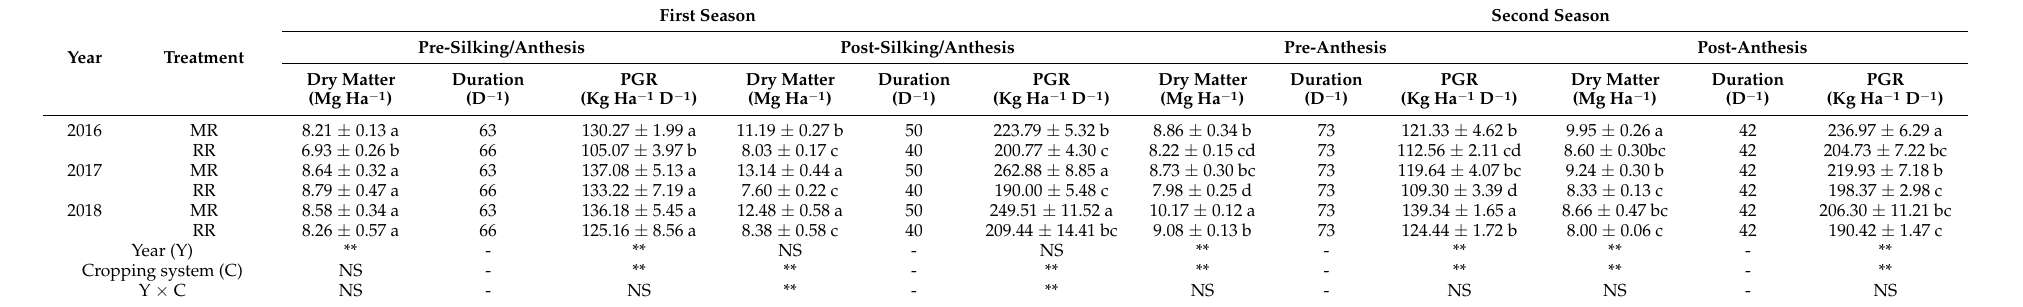
Table 5. Dry matter, growth duration, and plant growth rate (PGR) during pre- and post-silking under maize in MR and pre- and post-anthesis under rice under MR and RR treatments in Wuxue from 2016 to 2018.